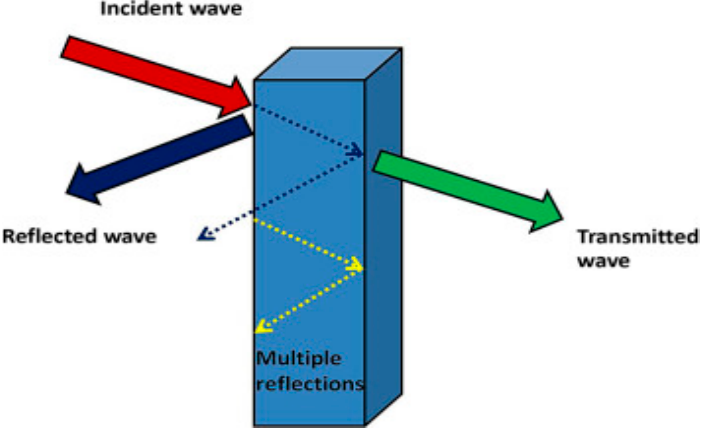
Figure 13. Schematic representation of EMI shielding (taken from [164]).